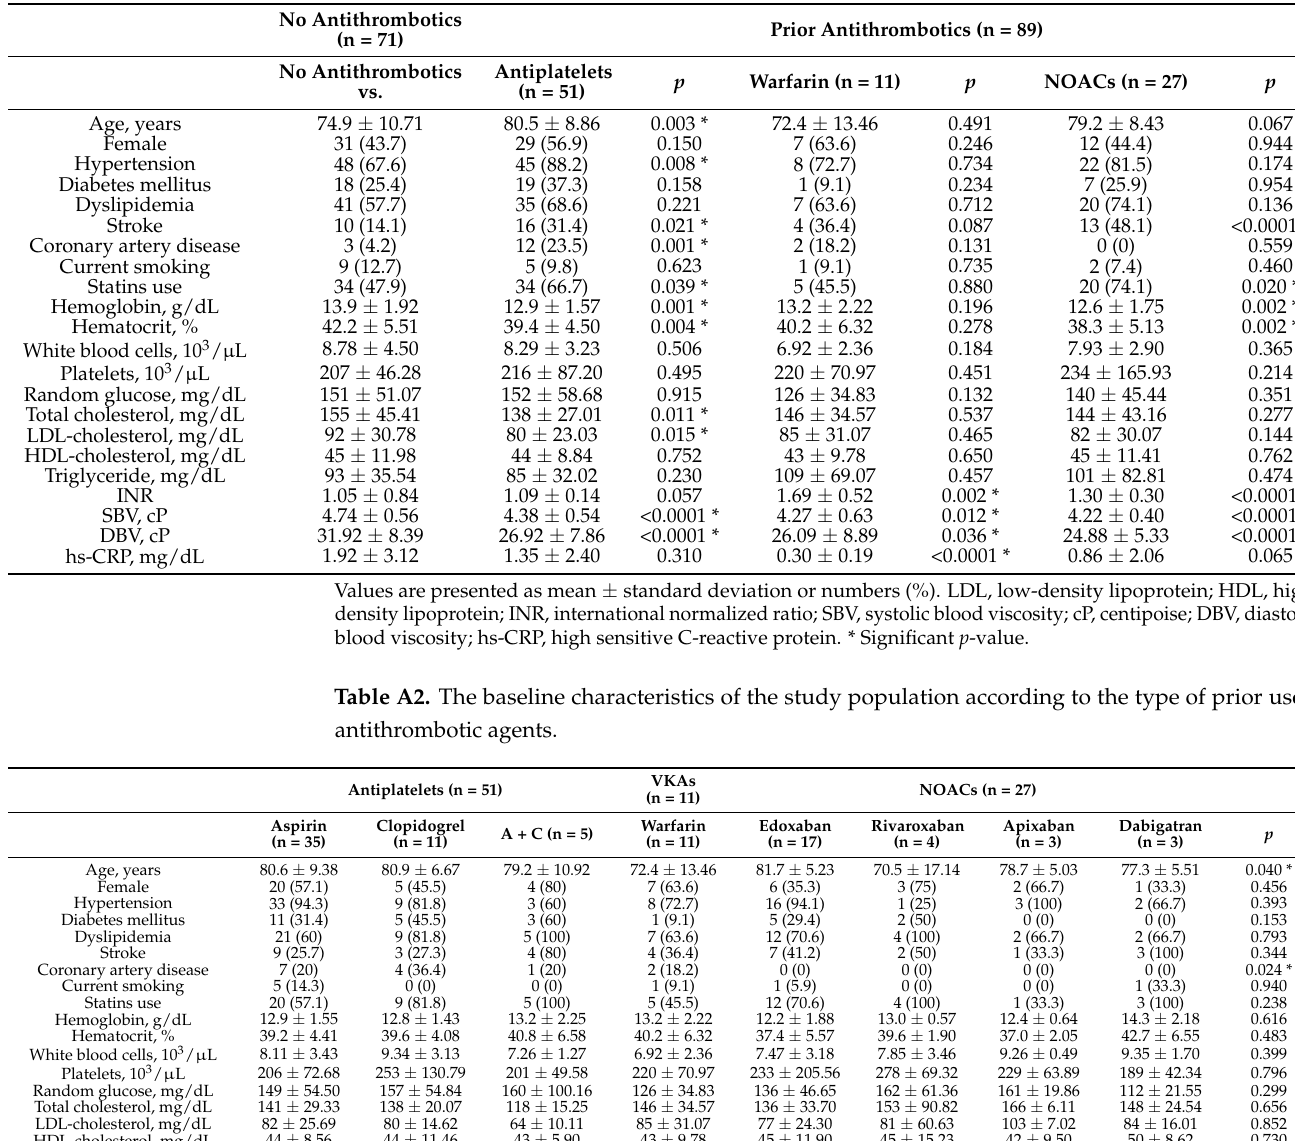
Table A1. The baseline characteristics of the study population among the no prior antithrombotics use group and each prior use of antithrombotic agent groups.